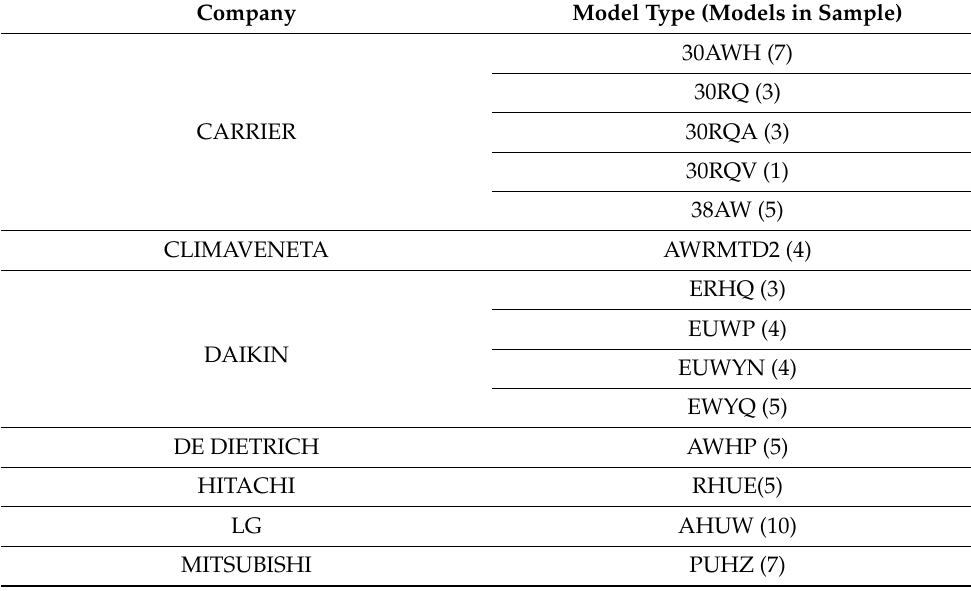
Table 2. Heat pumps manufacturers, types, and number of models (in brackets).